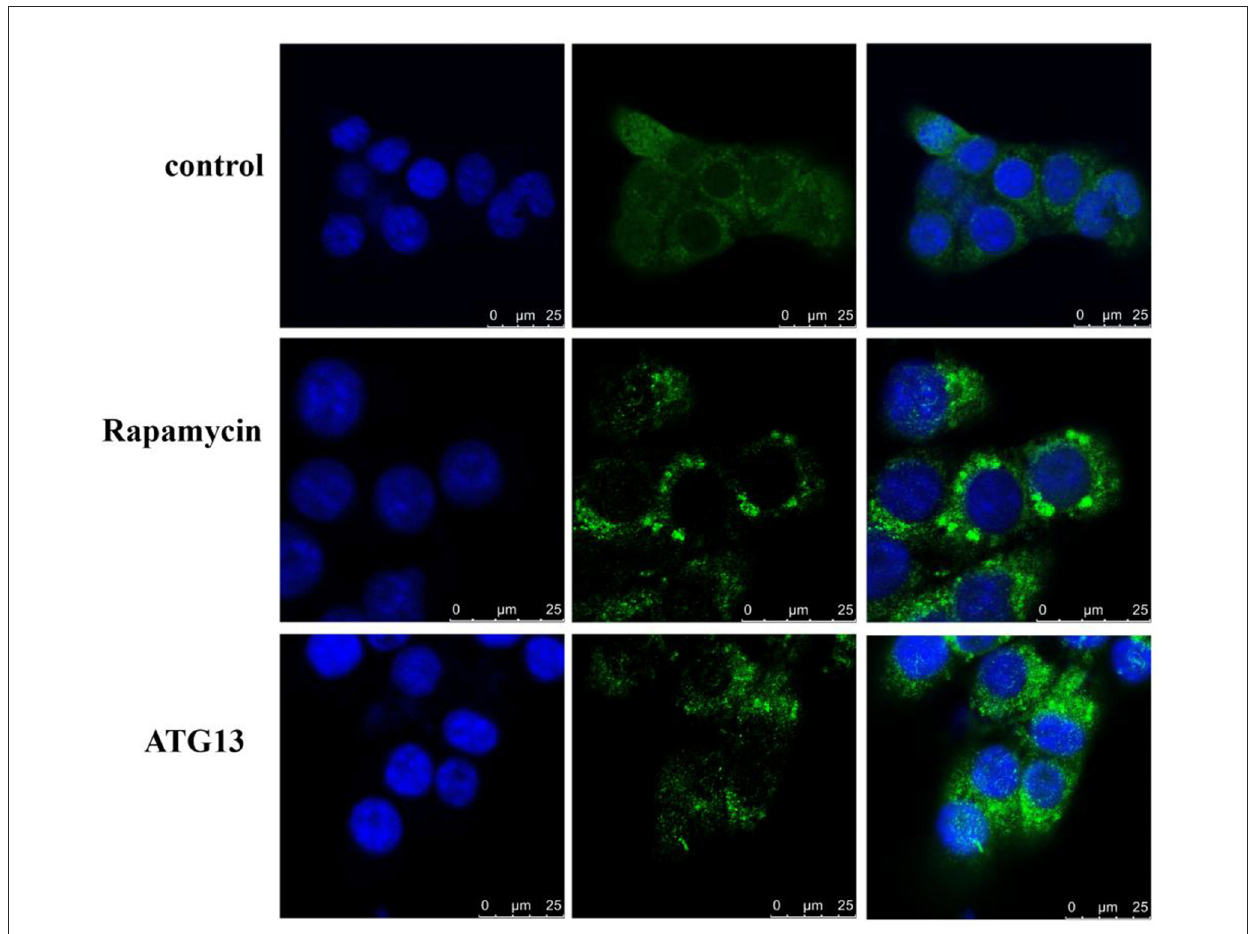
FIGURE8 Confocal fluorescence microscopy of autophagy puncta. HEK293T cells were transfected with GFP-LC3 plasmid alone or with pcDNA3.1-HA-TgSTING plasmid for 24h. For positive control, 100nM rapamycin was added into cells for another 24h. DAPI was used to stain cell nuclei. Scale bar = 25 µ